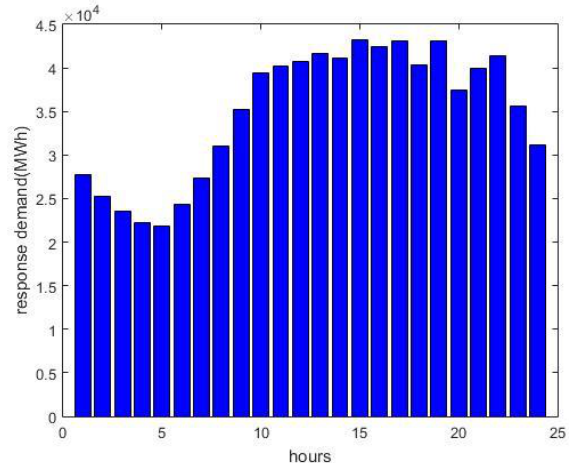
Table 4. Running results of Algorithm 2.